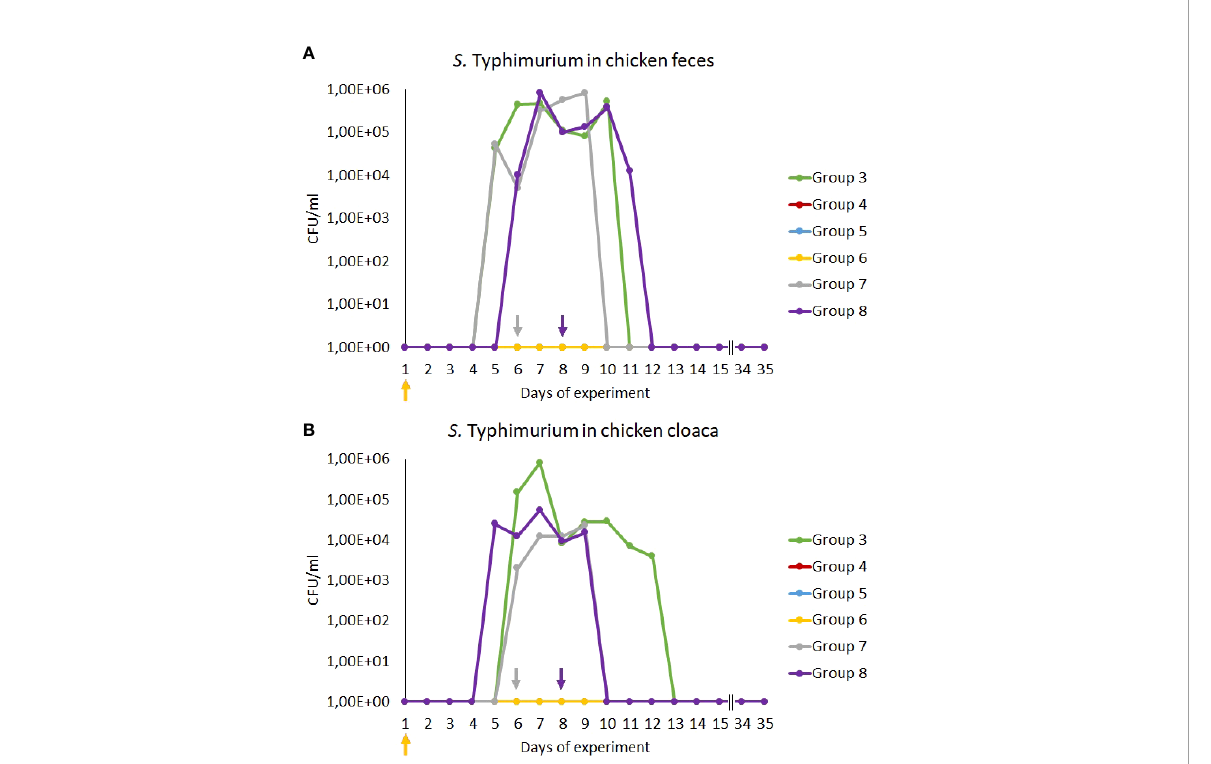
FIGURE 2 Prevalence of Salmonella Typhimurium 13 (CFU/ml) in chicken feces (A) and cloaca swabs (B) during the experiments. The days the groups began phage therapy are marked with arrows corresponding with colors to the group on the graph. No S. Typhimurium was isolated from samples from groups 4, 5 and 6, therefore, the lines overlap and are not visible on the